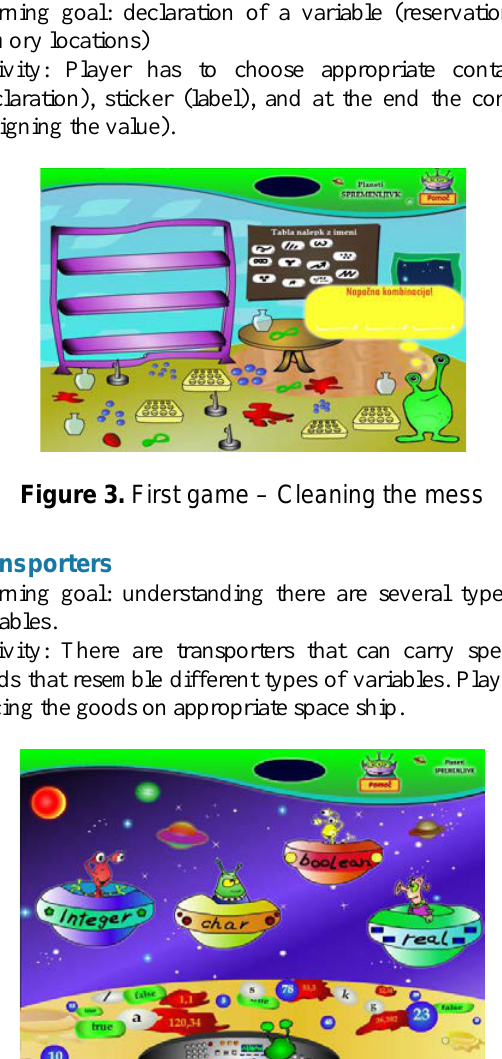
Figure 4. Second game – Transporters